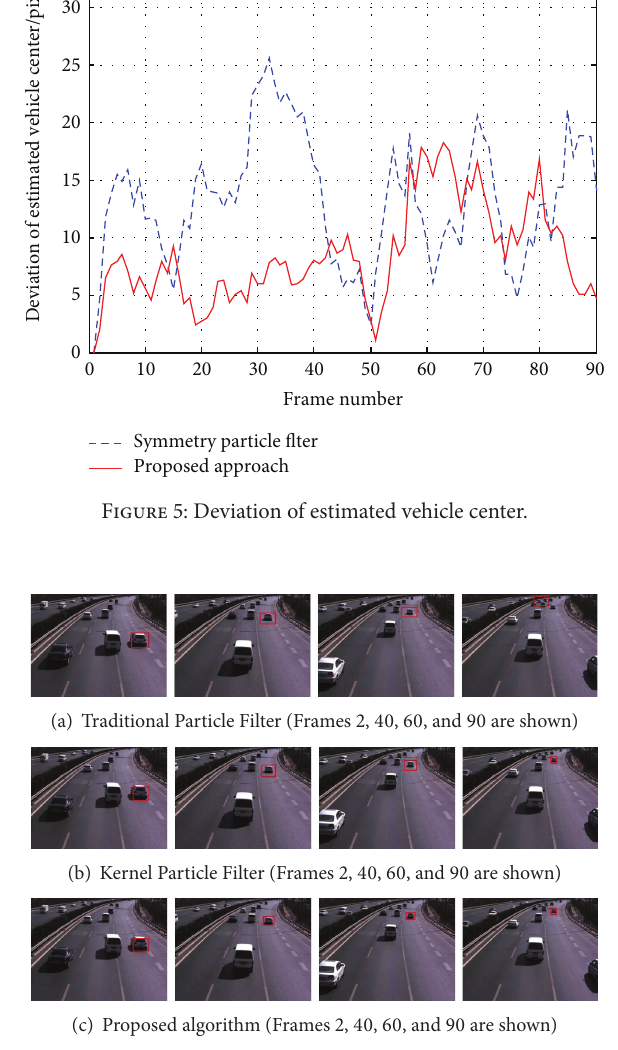
Figure 6: Tracking results of traditional PF, KPF and proposed